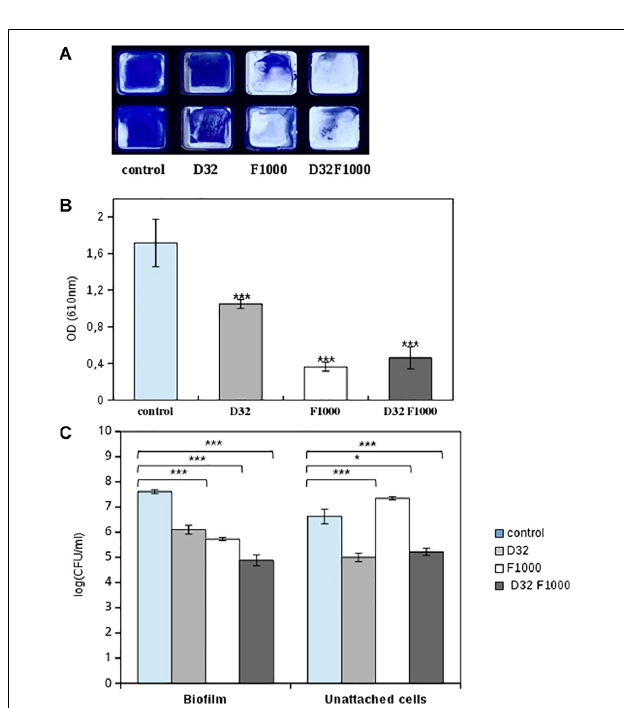
FIGURE 6 | Effect of 1,000 mg/L ficin (marked as F1000) and 32 mg/L dalbavancin (marked as D32) on preformed MRSA4 biofilms as measured by CV staining and viable CFU counting. (A) MRSA4 biofilm quantification by CV in flat-bottom 96-well Ibidi plates, performed by duplicate. (B) Biofilm formation capacity after different treatments and CV staining (measured as optical density). Data show average values from three biological replicates. (C) Bacterial viability of biofilm and planktonic MRSA4 cells after treatment by ficin, dalbavancin, and their combination for 24 h. Data show the average of log CFUs from three replicates. Statistical significance was assessed by t -test; asterisks indicate * p ≤ 0.05 and *** p ≤ 0.001.